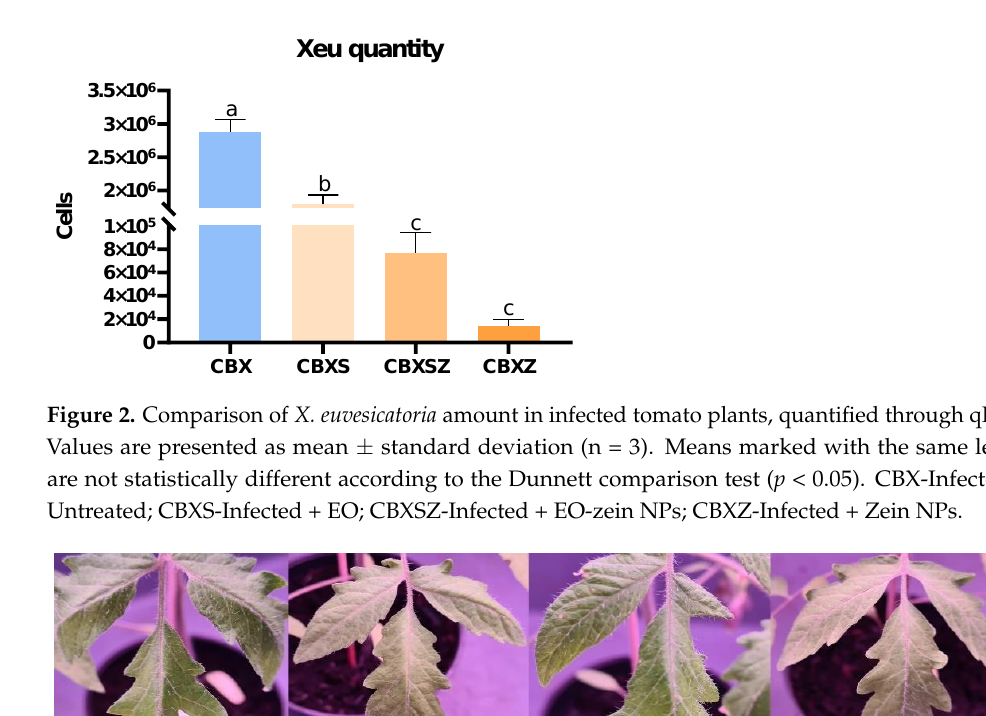
Figure 3. Disease symptom monitoring, 12 days after infection (10 days after treatments). ( a ) Uninfected + Untreated (CBC, negative control); ( b ) Uninfected + EO (CBS); ( c ) Uninfected + EO-zein NPs (CBSZ); ( d ) Uninfected + Zein NPs (CBZ); ( e ) Infected + Untreated (CBX, positive control); ( f ) Infected + EO (CBXS); ( g )-Infected + EO-zein NPs (CBXSZ); ( h ) Infected + Zein NPs (CBXZ).